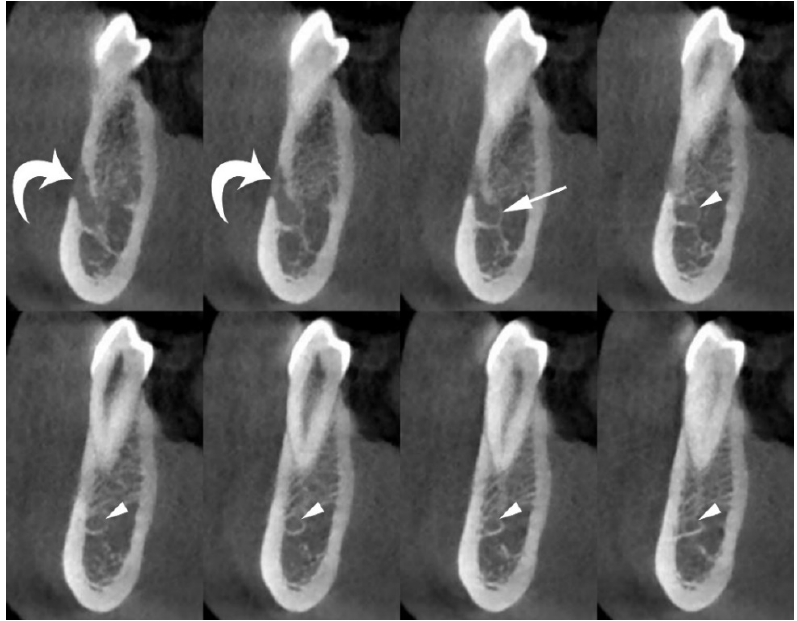
Figure 2. Cross-sectional CBCT images show the origin and position of the MIC (arrowheads) within the spongiosa of the mandible, and its relationships with adjacent anatomical landmarks (cortical plates and first premolar apex). The mental foramen (curved arrows), and anterior loop of mandibular canal (arrow) are also